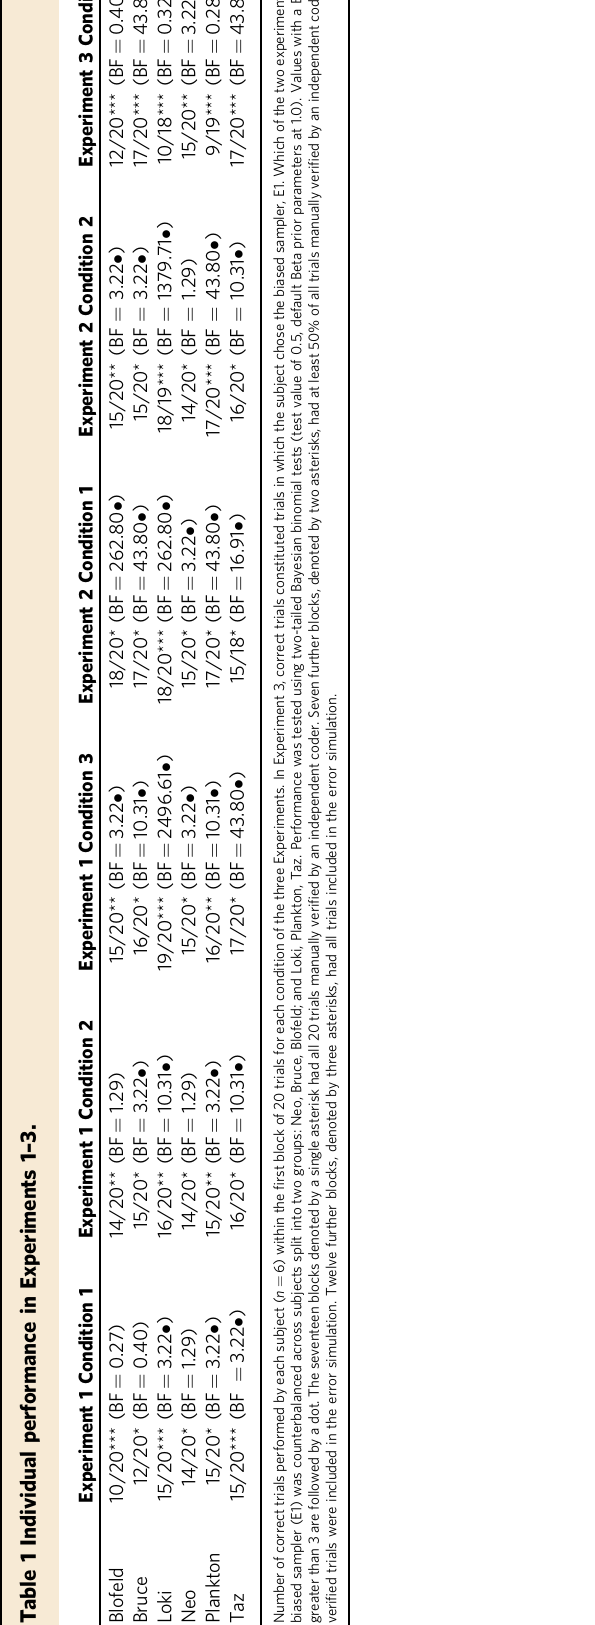
Table 2 Individual performance in experiment controlling for unintentional experimenter cues or